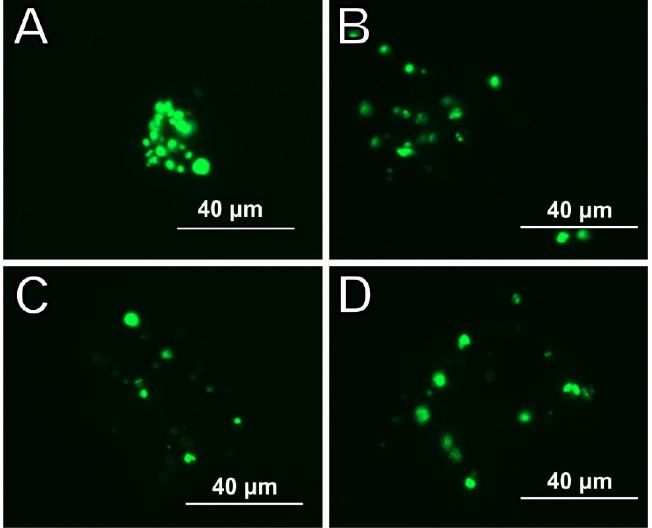
Figure 5. Expression of NeuN after 5 days of treating with frequencies ( A , B ) 40 Hz and ( C , D ) 100 Hz; ( A , C ) non-collagen; ( B , D )